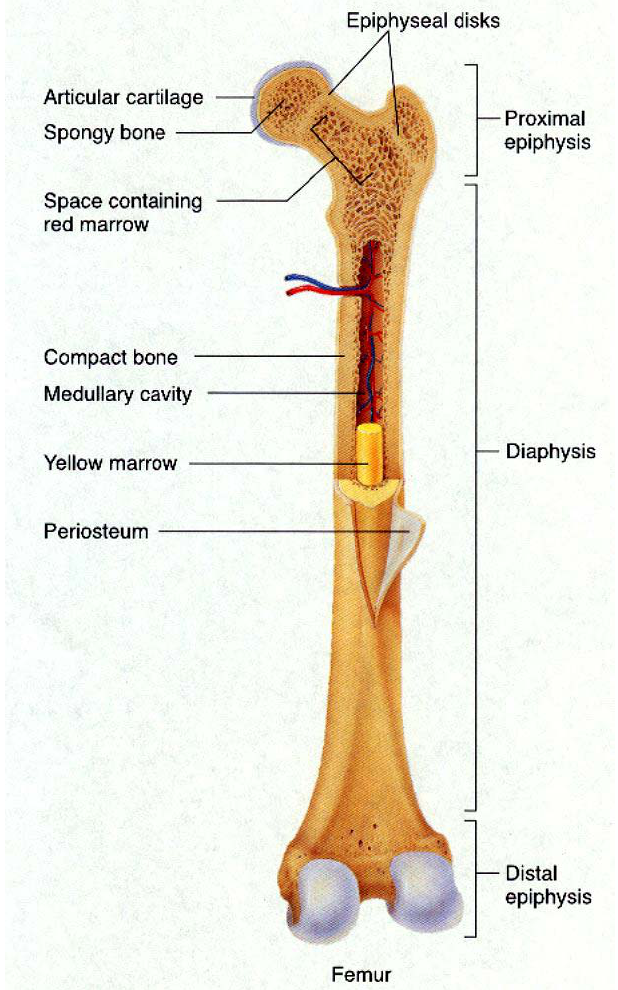
Figure 6. General structure of a mammalian bone. Other very good graphical sketches of the mammalian bone structure are available in Refs.